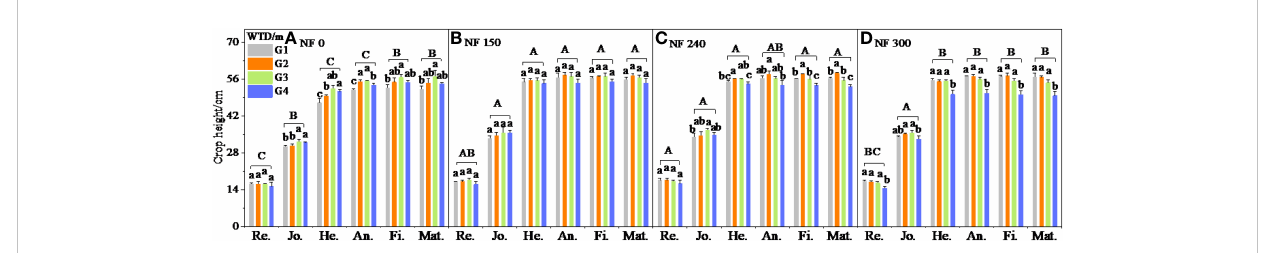
FIGURE 2 Winter wheat crop height at different growth stages. Re., Jo., He., An., Fi., and Mat. mean the regreening, jointing, heading, anthesis, fi lling, and maturity stage, respectively. Different lowercase letters indicate signi fi cant differences between different WTD under the same N application (P < 0.05), and uppercase letters indicate signi fi cant differences between different N application treatments (P < 0.05). The same is true